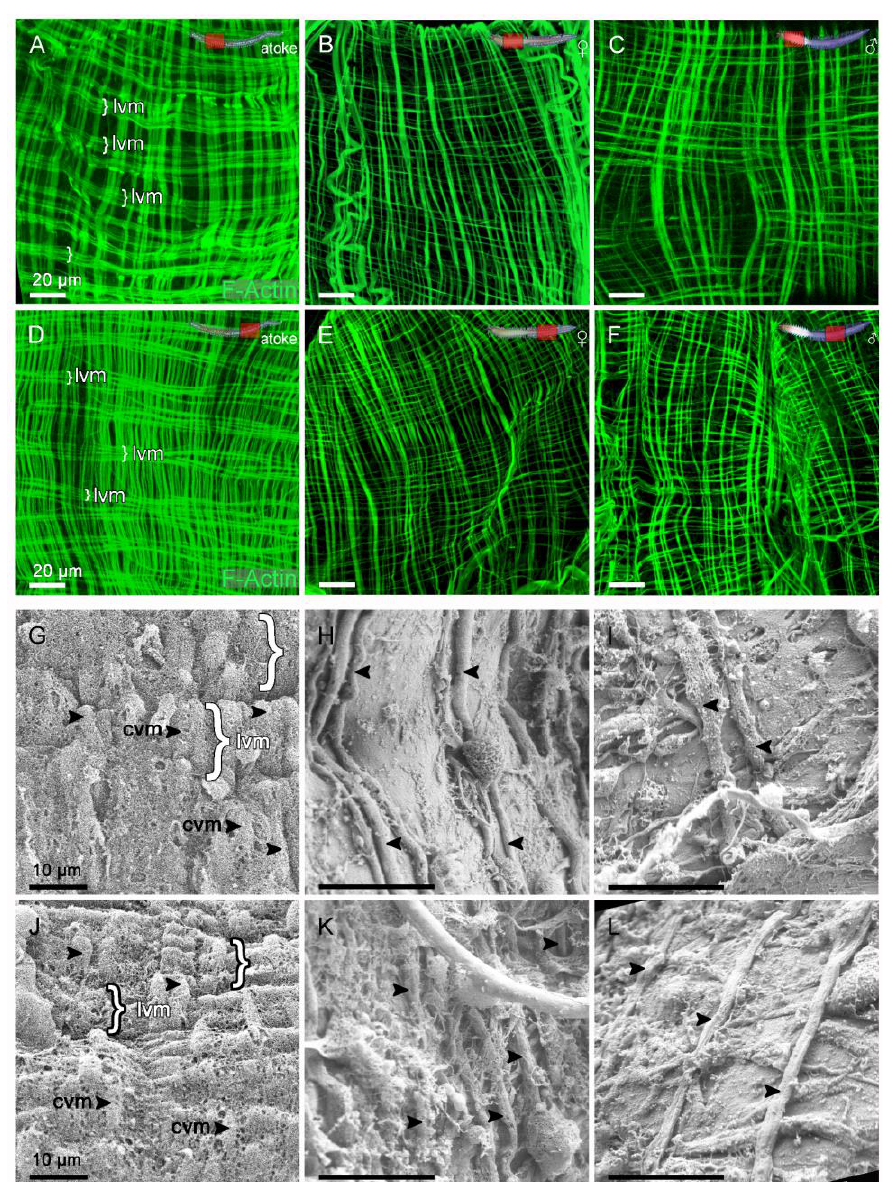
Figure 7. The number of visceral muscles and their coelothelial coverage is greatly reduced after sexual maturity. ( A – F ) The general morphology of the visceral muscles in ( A , D ) atokous, ( B , E ) female, as well as in ( C , F ) males in ( A – C ) anterior and ( D – F ) posterior segments of the same worm revealed by Phalloidin staining after spawning (F-Actin in green). ( A , D ) The atokous visceral musculature consists of a thin layer of circular and longitudinal muscles surrounding the midgut, whereby the longitudinal muscles are especially grouped into bundles (lm, brackets). ( B , C , E , F ) After the maturation, this network seems to have loosened up and the longitudinal muscles are more evenly distributed. ( G – L ) The ultrastructure of visceral muscles revealed by scanning electron microscopy (SEM). ( G , J ) The atokous visceral muscles, ( H , K ) female, as well as ( I , L ) male epitokous muscles in ( G – I ) anterior and ( J – L ) posterior segments of the same worm. ( G , J ) High magnification SEM of the atokous visceral muscles mainly reveals the parallel aligned circular muscles (cm, arrow- heads) and the longitudinal muscle bundles (lm, brackets) both covered with a fenestrated coelothel. ( H , I , K , L ) After maturation, only circular and longitudinal muscles that are further apart can be found under the most severely dissolved coelothel. Abbr.: cvm circular visceral muscle, lvm longitudinal visceral muscle. Scale bars = ( A – F ) 20 µ m, ( G – I ) 10 µ Therefore, we also analyzed the visceral musculature in more detail (Figure 7; Figure S3; Figure S4), which has been described as a layer of smooth longitudinal and circular